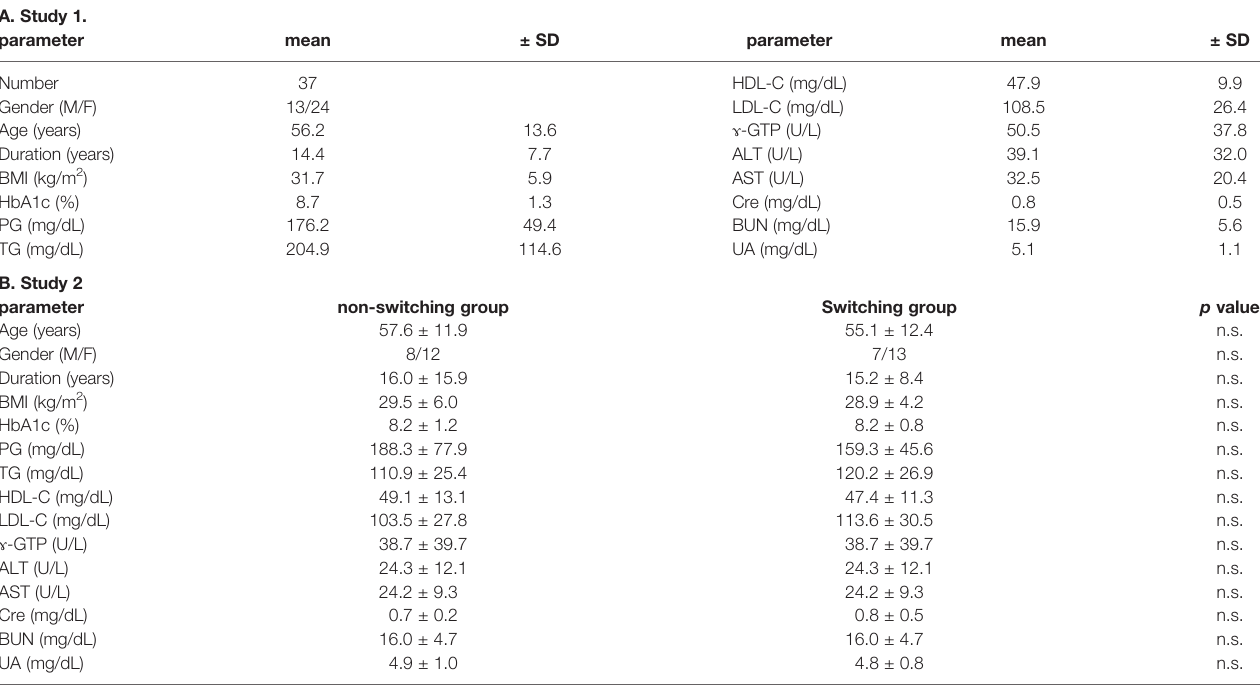
TABLE 1 | Clinical baseline characteristics of the subjects in this